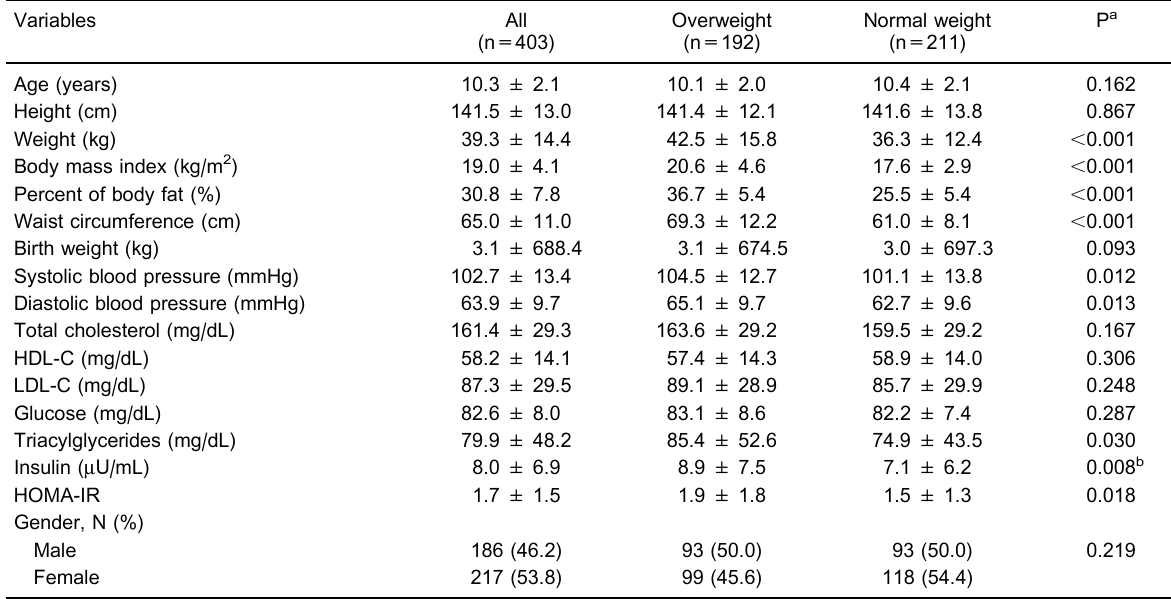
Table 1. Selected characteristics of overweight and normal weight